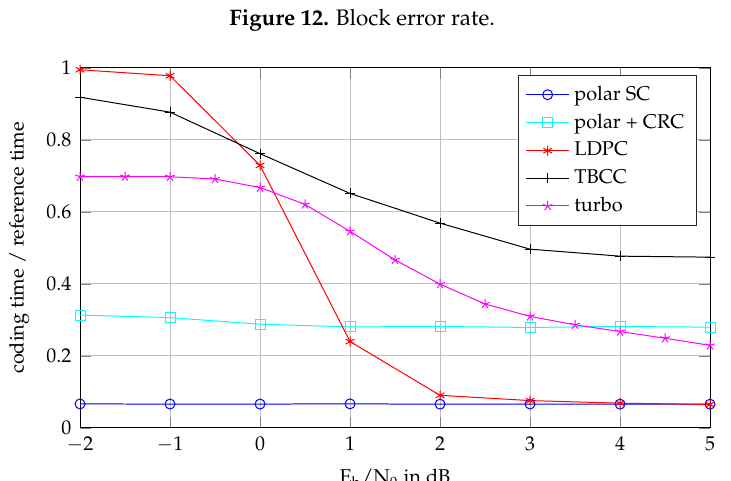
Figure 12. Block error rate.